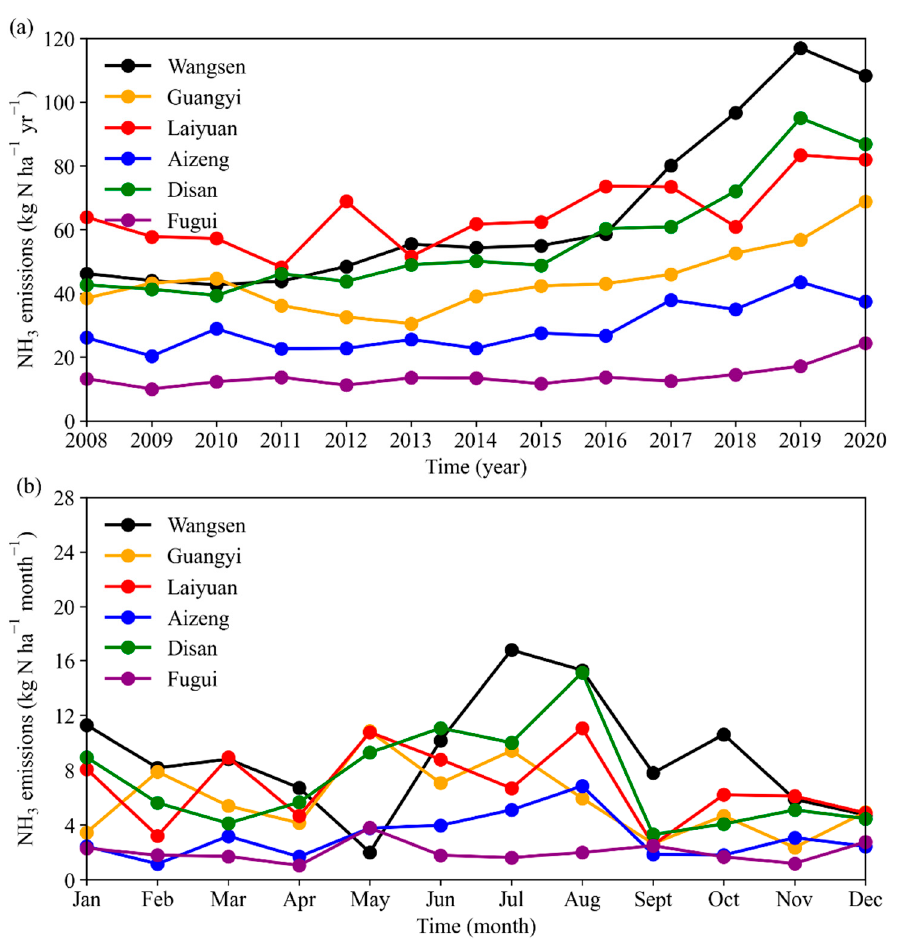
Figure 4. Annual and monthly NH 3 emissions from the feedlots. ( a ) Annual variations of NH 3 emissions from the feedlots during 2008–2020; ( b ) Monthly variations of NH 3 emissions from the feedlots in 2020.